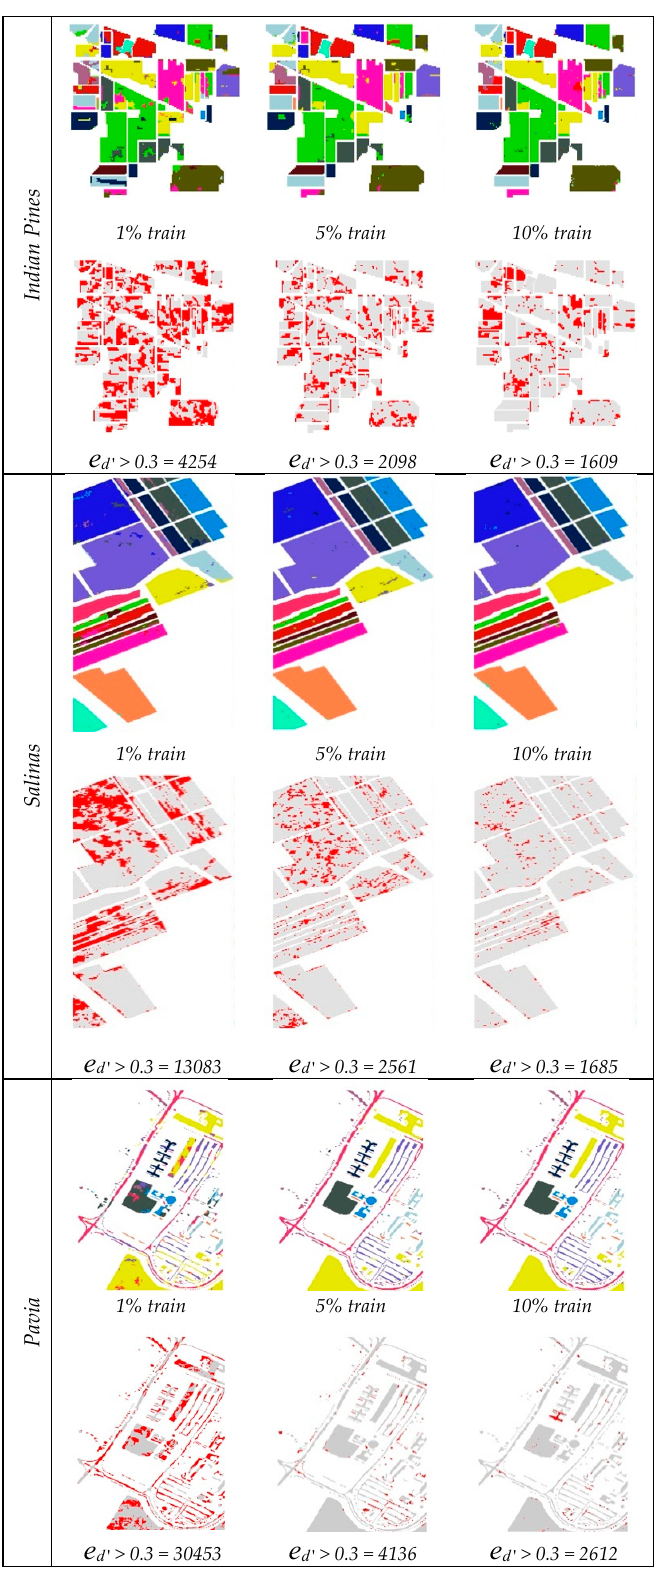
Figure 5. The DoTRules classification results and estimated pixel-based e d (cid:48) , for the Indian Pines, Salinas and Pavia datasets. The red pixels show the location of unreliable rules according to entropy thresholding ( e d (cid:48) > 0.3, for α = 0.05), while the grey pixels are reliable rules above the threshold. The red pixels are counted for each sample size.